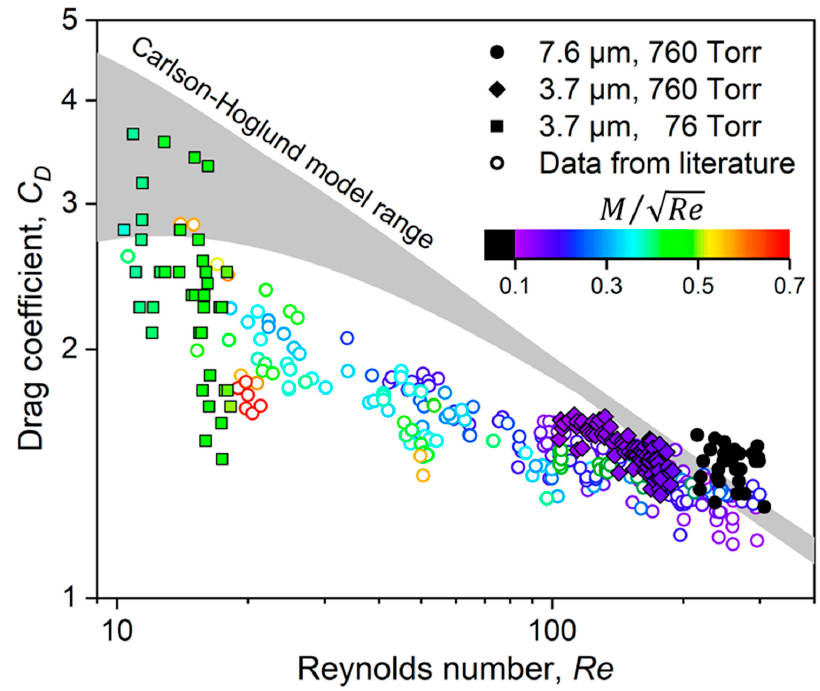
Figure 4. Drag coefficient, C D , vs. Reynolds number, Re , at 1.2 < M < 4 for the three supersonic experimental conditions are displayed with the data of Kane [12], Wegener and Ashkenas [13], Aroesty [14], and Bailey and Hiatt [15]. The shaded region indicates the Carlson ‐ Hoglund model’s range for 1.2 < 𝑀 < 4. Data points are colored according to the 𝑀/√𝑅𝑒 flow regime metric from 0.1 to 0.7, where increasing values correspond to increasingly rarefied conditions. Data points in black with 𝑀/√𝑅𝑒 < 0.1 belong to the slip ‐ flow regime.